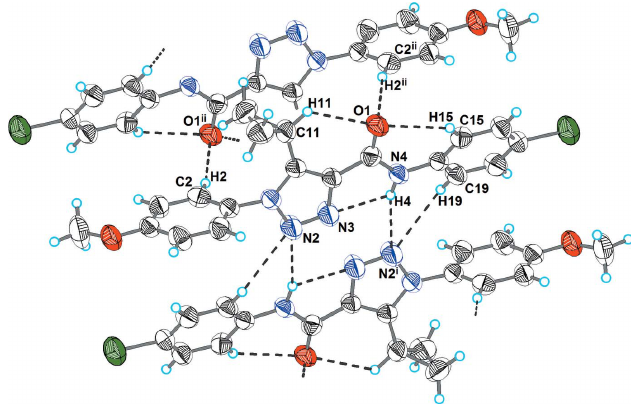
Figure 1 The molecular structure of the title compound with displacement ellipsoids drawn at the 50% probability